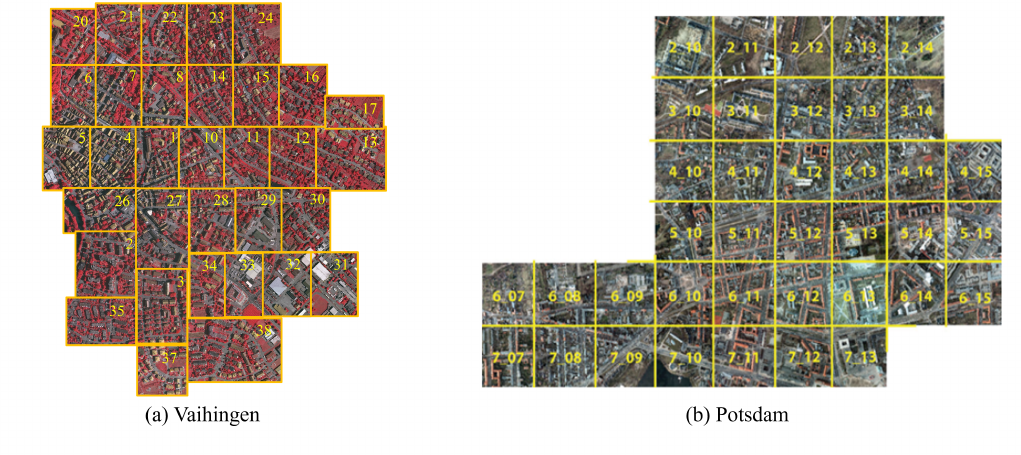
Figure 6. The detailed image patch location and corresponding number of the Potsdam and Vaihin- gen